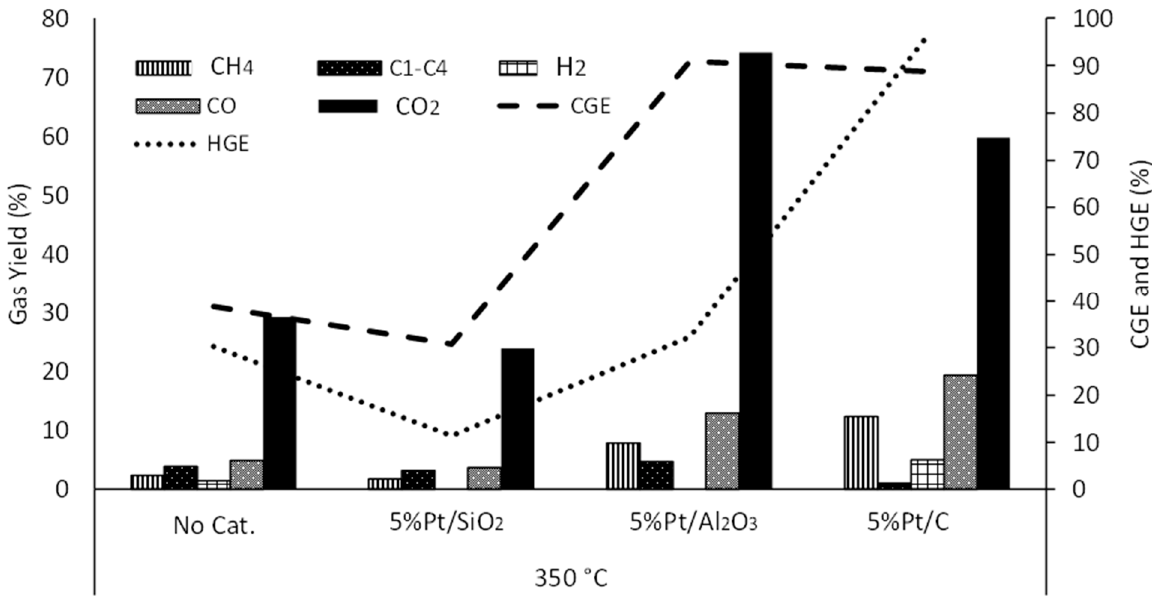
Figure 5. Effect of temperature on catalytic reforming of glycerol without and with the Pt ‐ based catalysts.